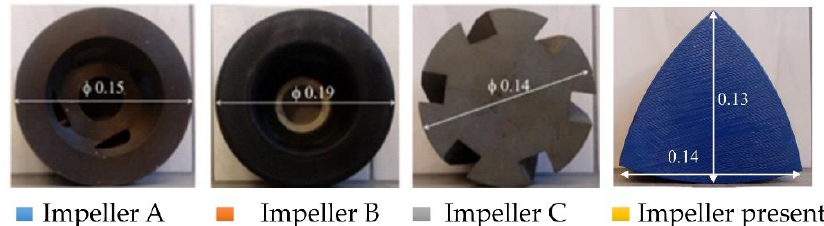
Figure 6. View of the four impellers for which the result of the refining time needed to remove 90% of dissolved oxygen was compared, dimensions in m.